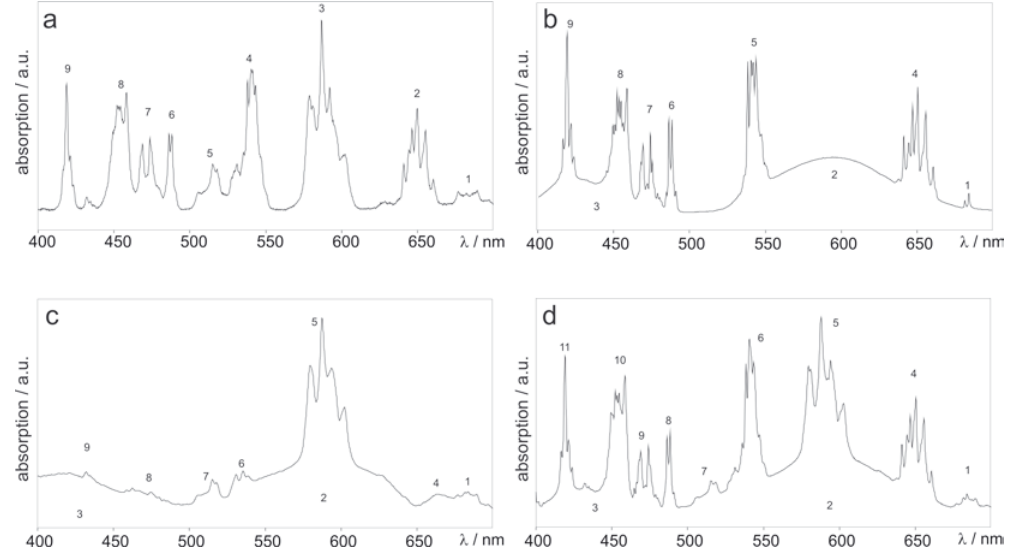
Figure 2. Ho,Nd:YAB (a); Ho,Cr:YAB (b), Nd,Cr:YAB (c) and Ho,Nd,Cr:YAB (d) absorption spectra. The peak assignments are given in Tab. 1.